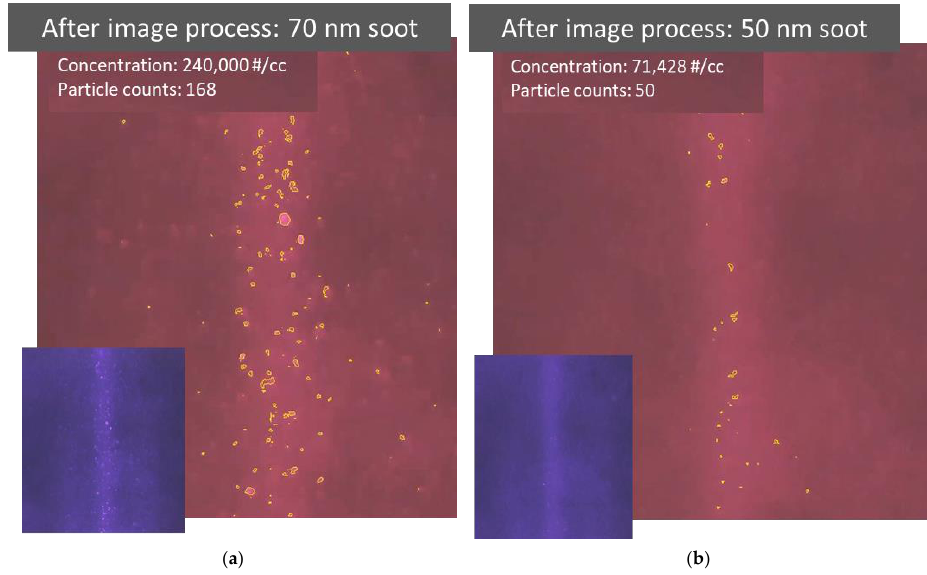
Figure 6. Results after image processing to extract quantitative information from videos recording particle light scattering. ( a , b ) Photos taken after image processing of videos recorded while detect- ing 70 and 50 nm soot particles, respectively. The original video image prior to processing is at- tached in the bottom left corner. Particles identified by the image processing code are highlighted using a yellow outline. The number count and concentration of identified particles are also pro- vided.